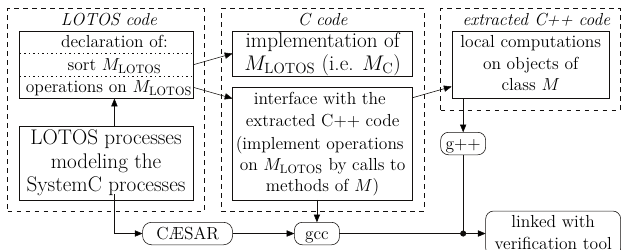
Figure 1 Verification of hybrid LOTOS/C++ models.